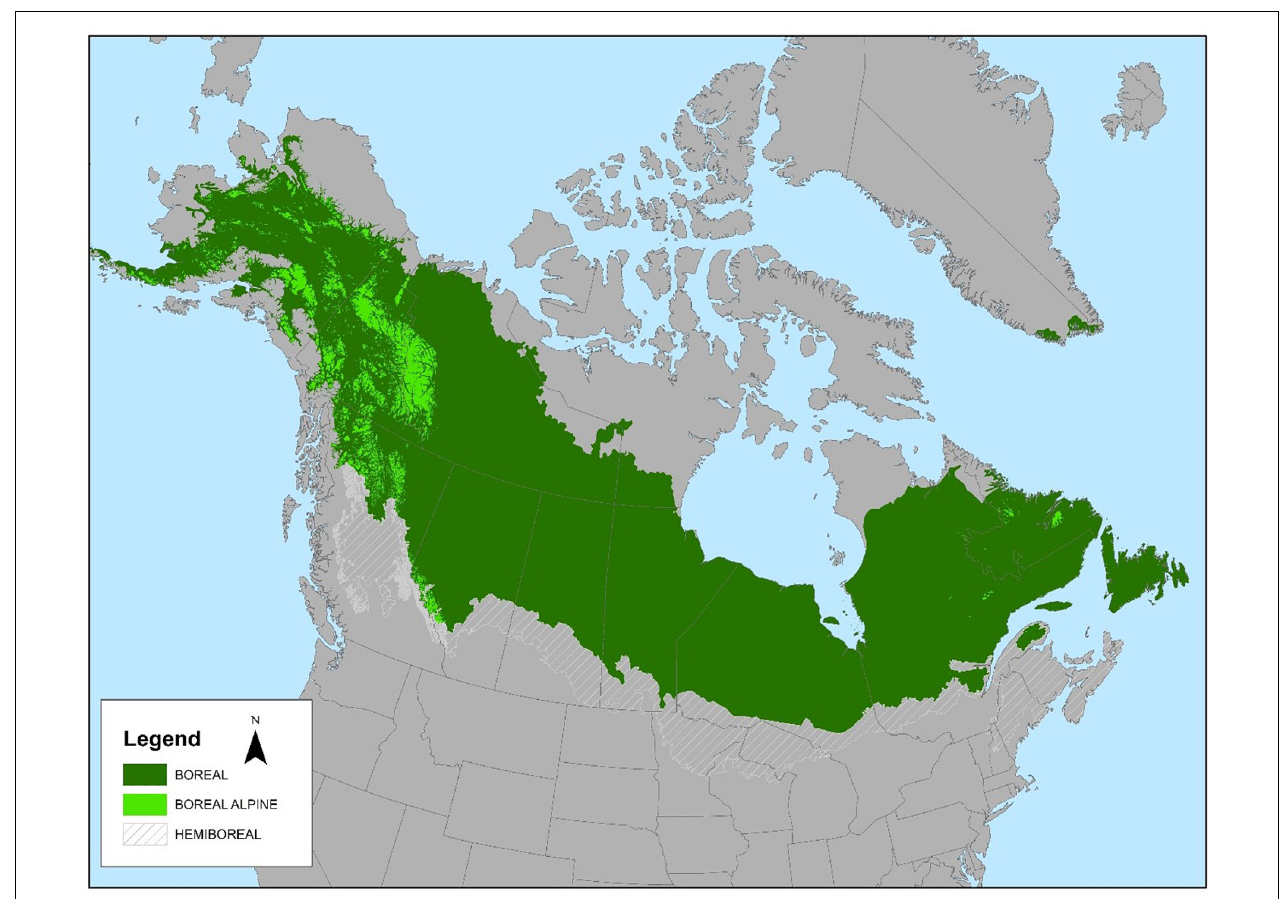
FIGURE 2 | The North American Boreal Forest biome as defined in Brandt (2009). The biome is estimated to harbor 25% of the world’s remaining intact